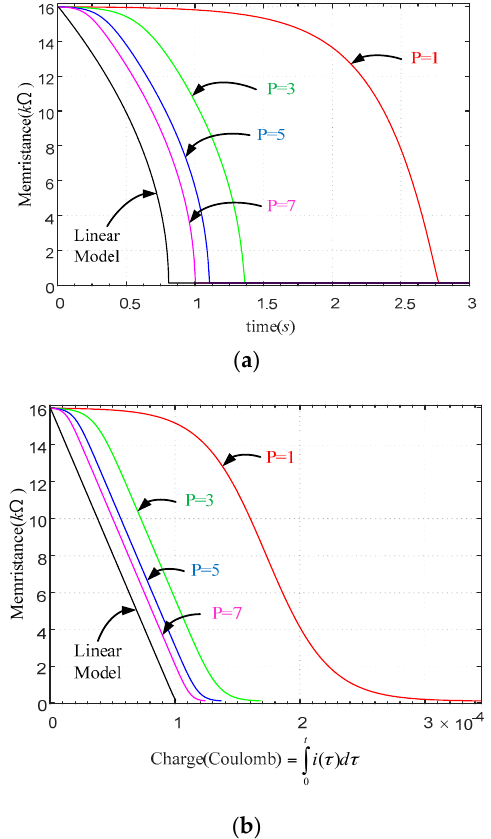
Figure 5. Memristance variation of a nonlinear memristor of (Equation of Window function) about: ( a ) time; ( b ) charge when a rectangular pulse is applied.